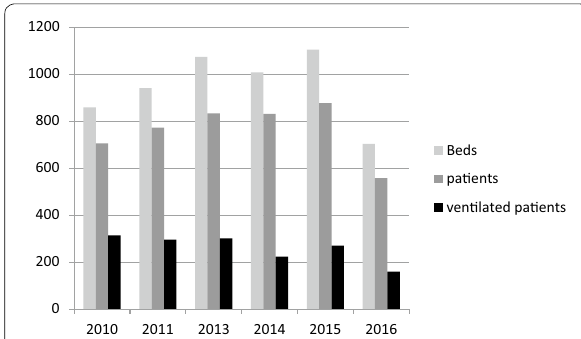
Fig. 1 Evolution of the number of ICU beds, patients and ventilated patients in participating